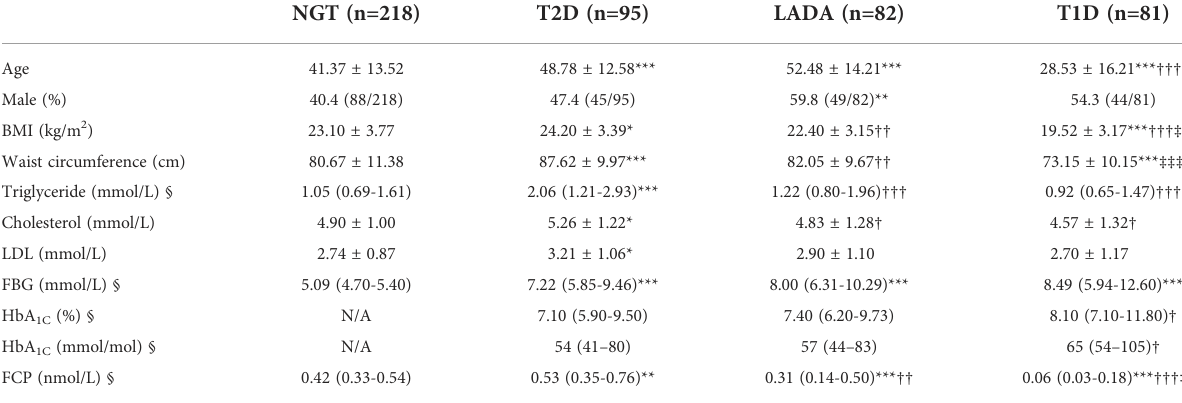
TABLE 1 Anthropometric and metabolic data of NGT subjects and T2D, LADA and T1D